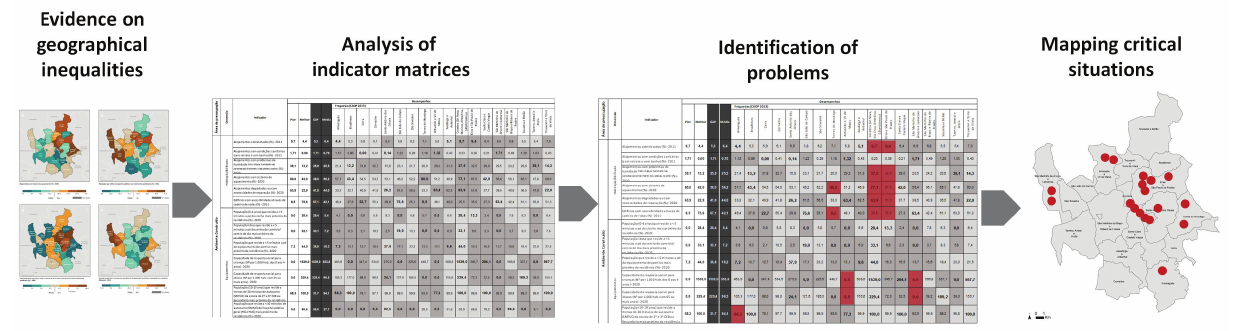
Figure 4. The evidence‐based matrix methodology to assess problems during the stakeholder workshop. Note: Illustrative example for the Built Environment dimension.